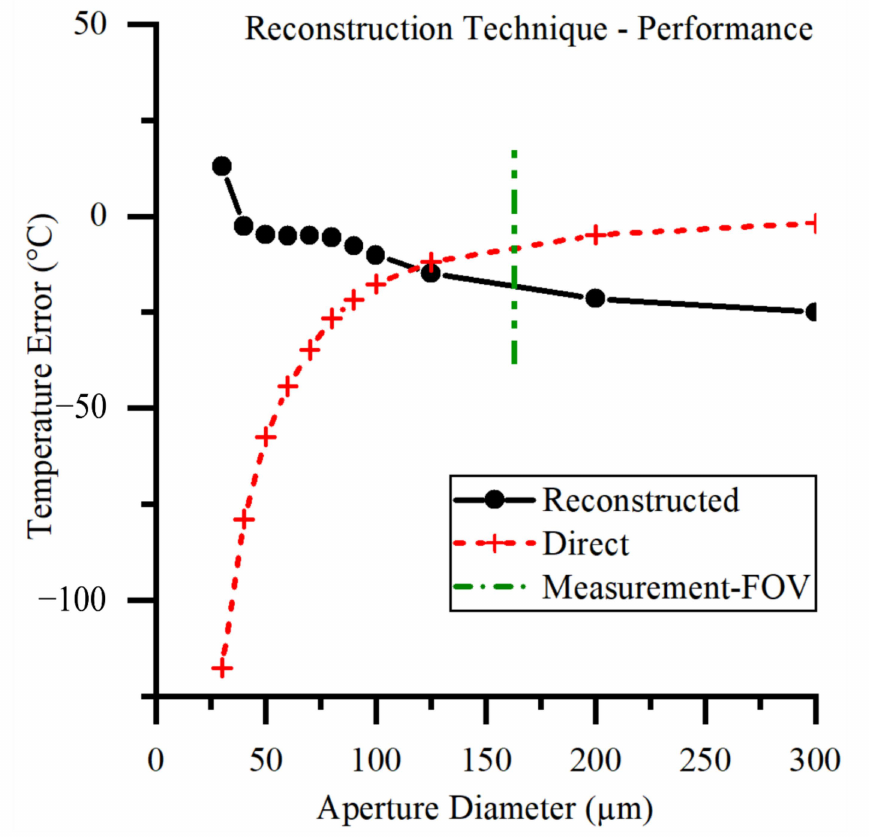
Figure 12. Accuracy of thermal field reconstruction for a series of uniform circular apertures. An idealized measurement or a perfect reconstruction technique would be a horizontal line at 0 ◦ C